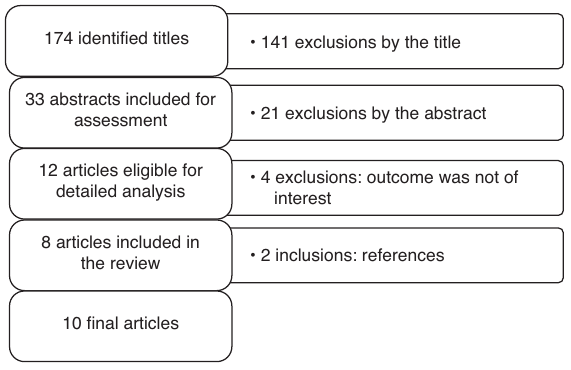
Flowchart of article